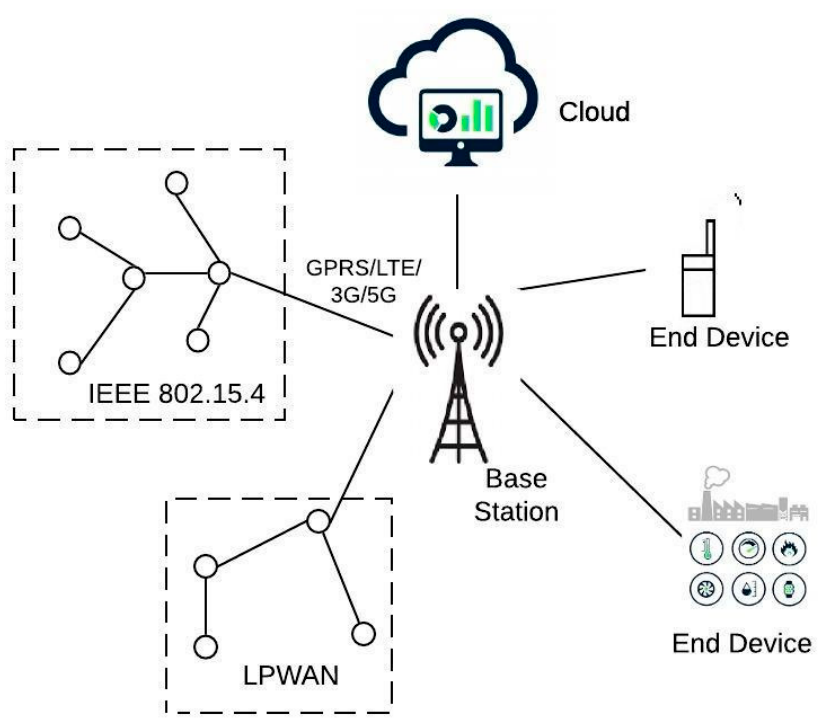
Figure 5. Generalized cellular type architecture.